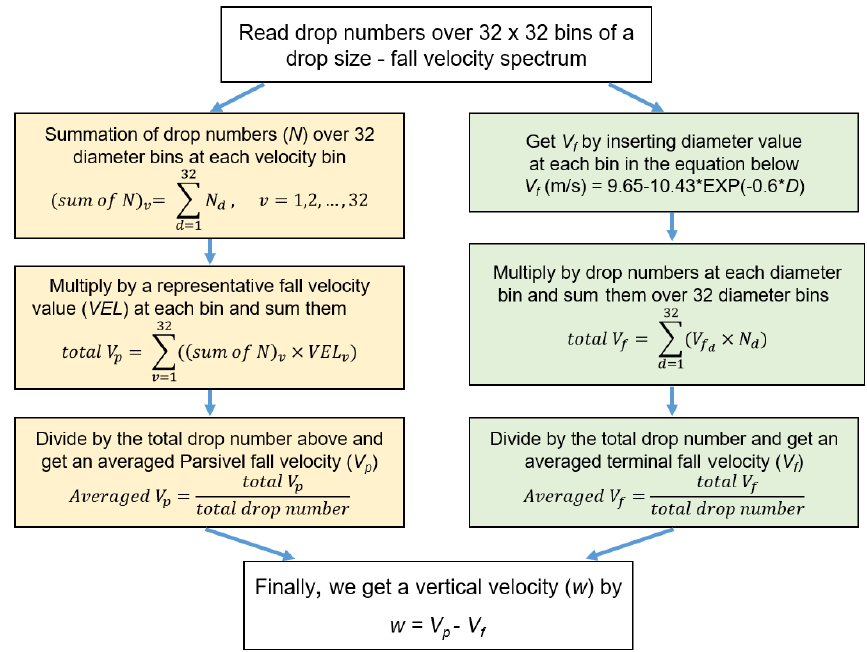
Figure 2. Flowchart for estimating w from a diameter – fall velocity spectrum of Parsivel (1min interval). See text for more details.